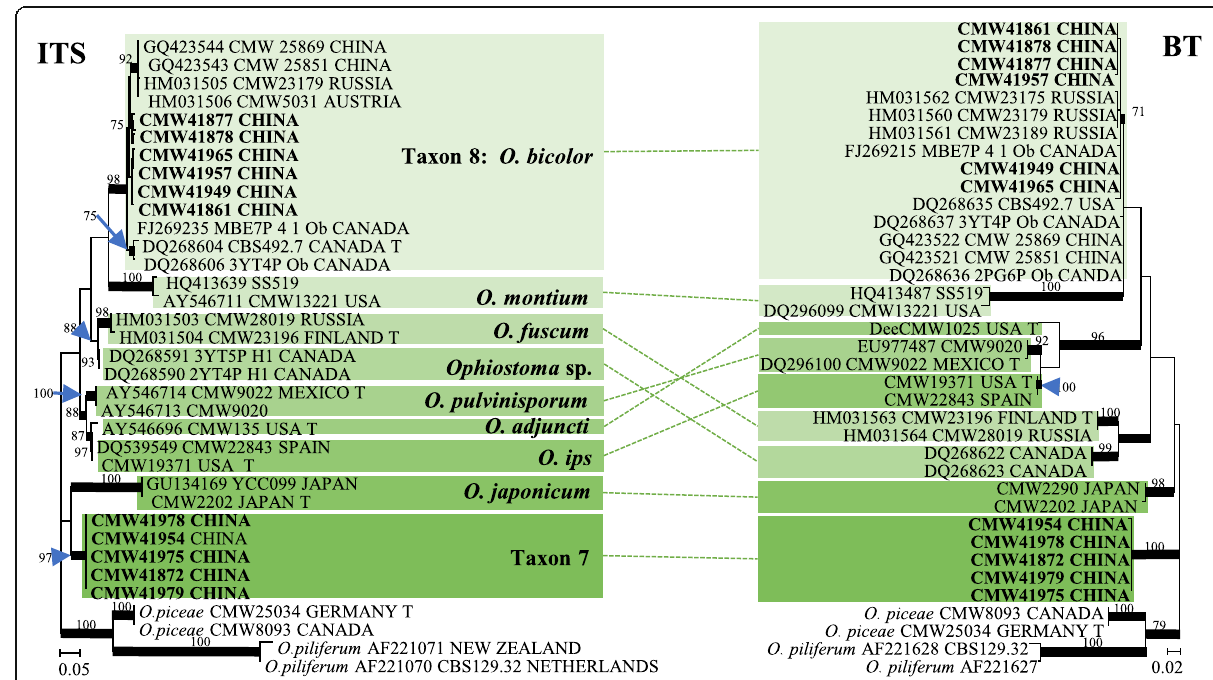
Fig. 4 Phylogram obtained from ML analyses of the ITS region and the partial BT gene of O. ips complex. Sequences obtained in this study are printed in bold type. ML bootstrap support values (1000 replicates, normal type) above 75% are indicated at the nodes. Posterior probabilities (above 0.9) obtained from BI are indicated by bold lines at the relevant branching points. T = ex-type cultures. Scale bar = total nucleotide difference between